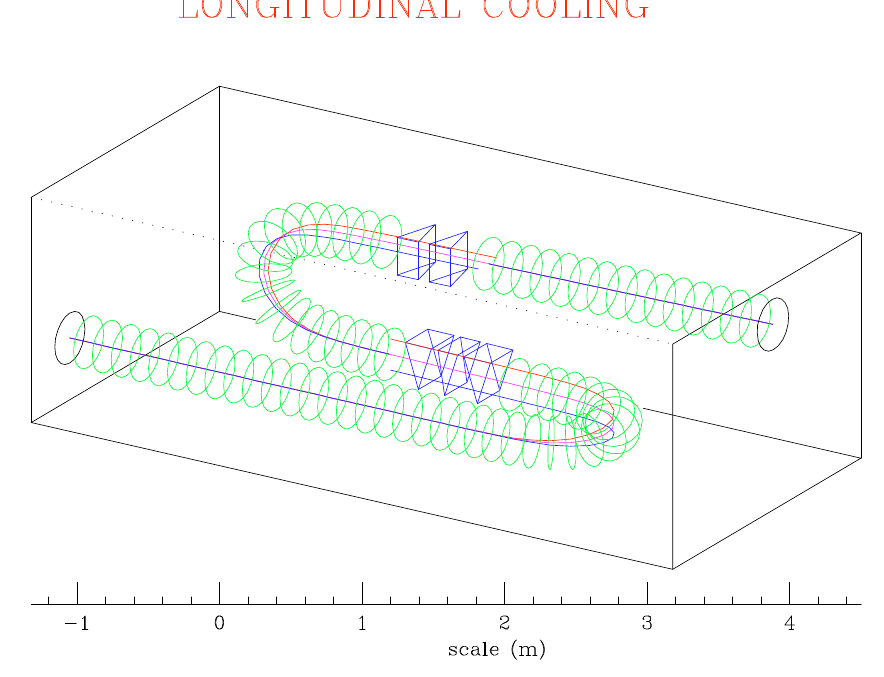
FIG. 17. (Color) One possible emittance exchange option.